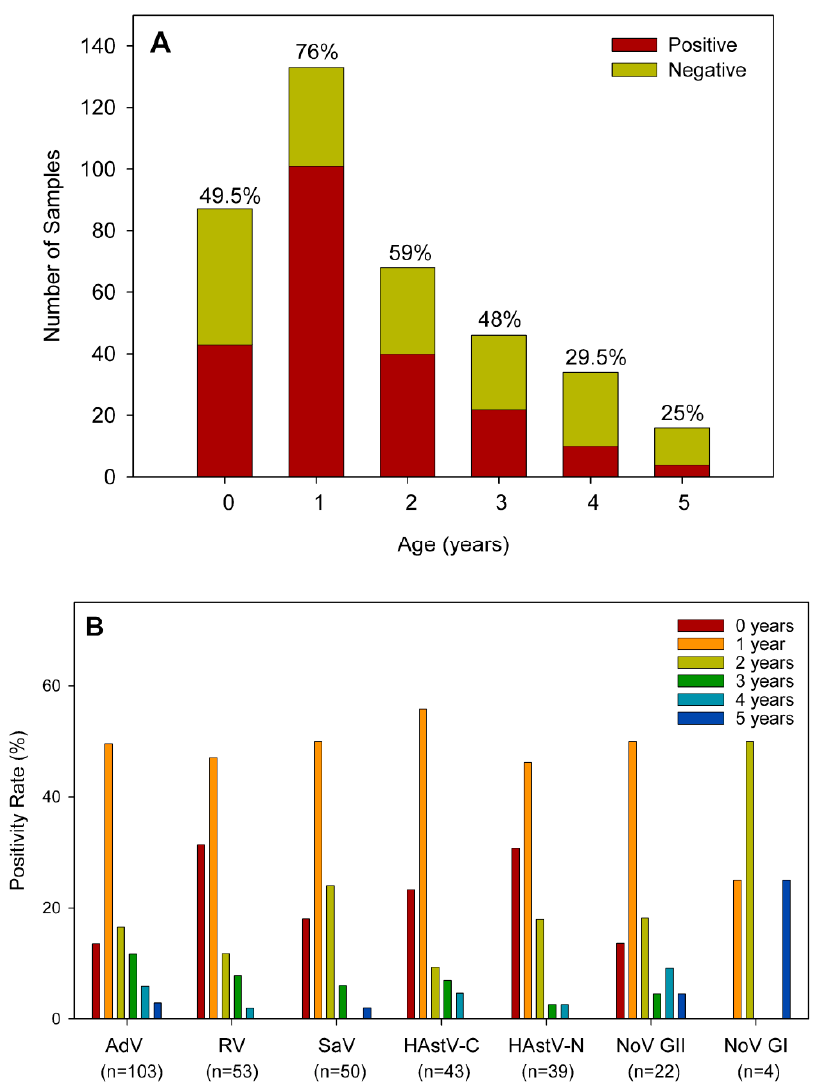
Figure 1. ( A ) Distribution of positive samples for any viral target by age groups. Percentages above each bar indicate the positivity rate in each group category. ( B ) Percentage distribution of positive samples by age group for each viral target. The number in brackets indicates the total number of positive samples for each virus. AdV: adenovirus; RV: rotavirus; SaV: sapovirus; HAstV-C: classic human astrovirus; HAstV-N: novel human astrovirus; NoV: norovirus: GI: genogroup I; GII: genogroup II.